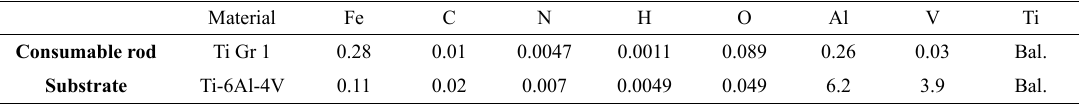
Table 1. Chemical composition provided by supplier in